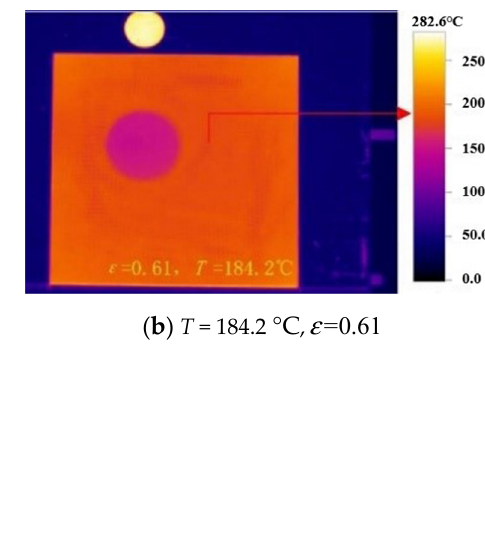
Figure 9. Radiation temperatures of damaged areas, shedding, and wear (181.1 °C real temperature).